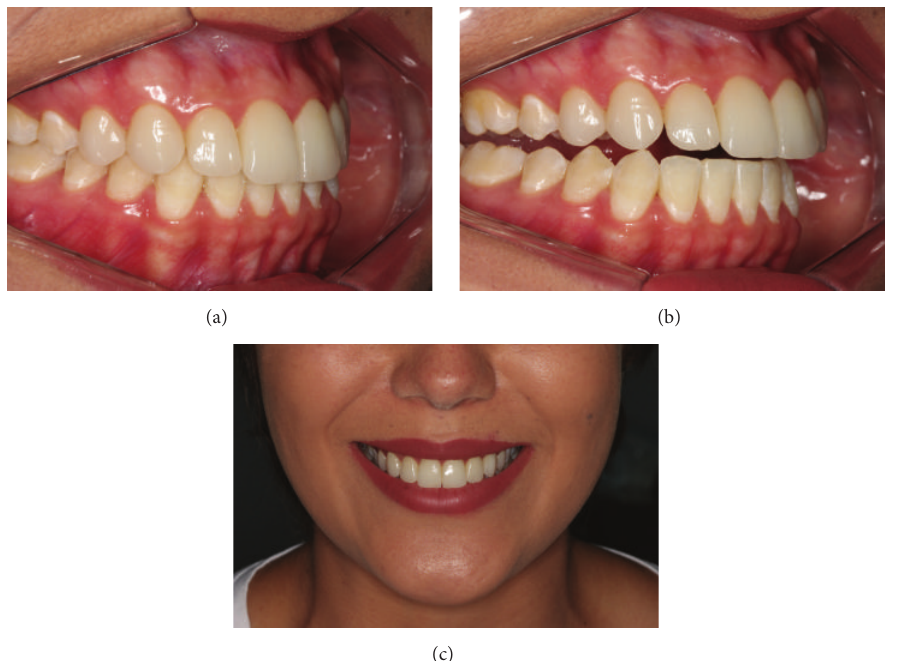
Figure 11: (a), (b), (c) Occlusal and periodontal control and esthetic stability of restorations after 18 months of